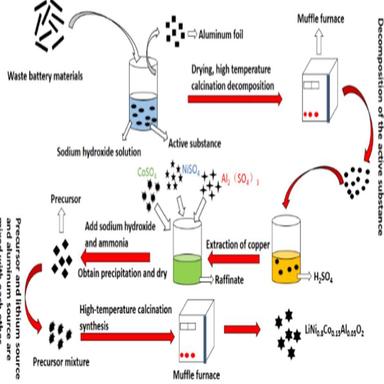
Flow chart of the regeneration process.